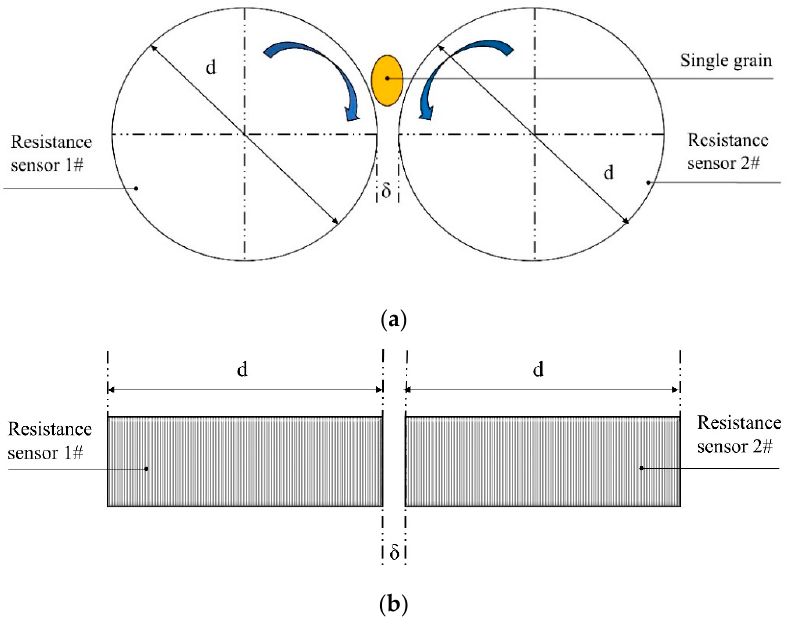
Figure 1. Structure of the single grain moisture sensor: ( a ) front view; ( b ) top view. Note: σ and d are the gap width between rollers and the diameter of rollers, respectively.